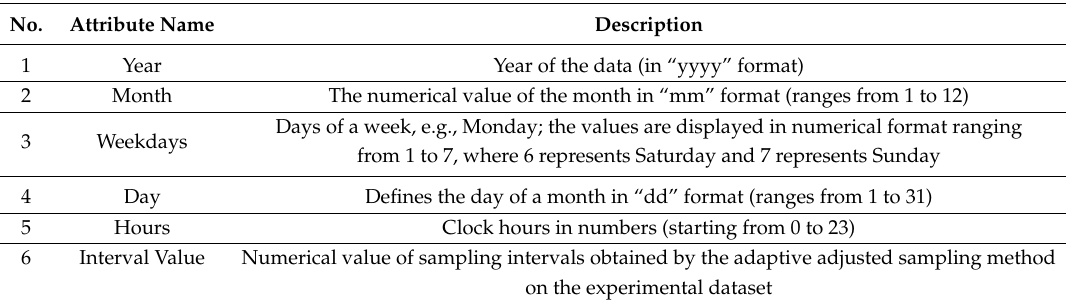
Table 1. Schema of the experimental